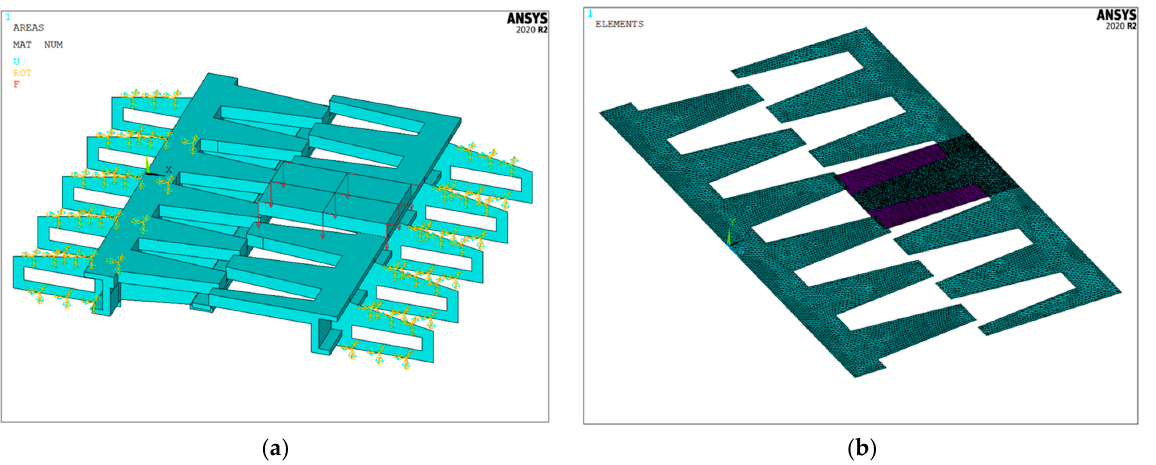
Figure 4. The finite element modelling for working condition II: ( a ) FEM of comb plate expansion, ( b ) The contact pair.